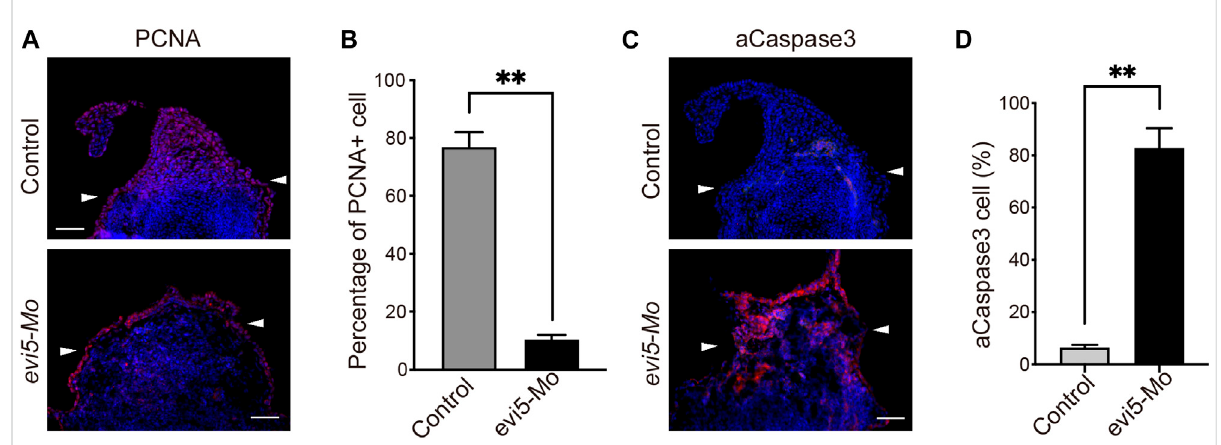
FIGURE 4 Proliferation and apoptosis of Xenopus tadpole limb blastema after Evi5 knockdown. (A) Immuno fl uorescence staining of PCNA (red) in evi5 Mo-injectedNFstage52tadpolehindlimbsat3dpa.NucleiwerecounterstainedwithDAPI,showninblue. (B) QuantitativeanalysisofPCNA-positive cells in the limb stump mesenchyme, distal to the level marked by white arrowheads. ** indicates signi fi cant difference, p < 0.01, n = 3, t-test. (C) Immuno fl uorescence staining of active Caspase3 (aCaspase3, shown in red) in evi5 Mo-injected NF stage 52 tadpole hind limbs at 3 dpa.